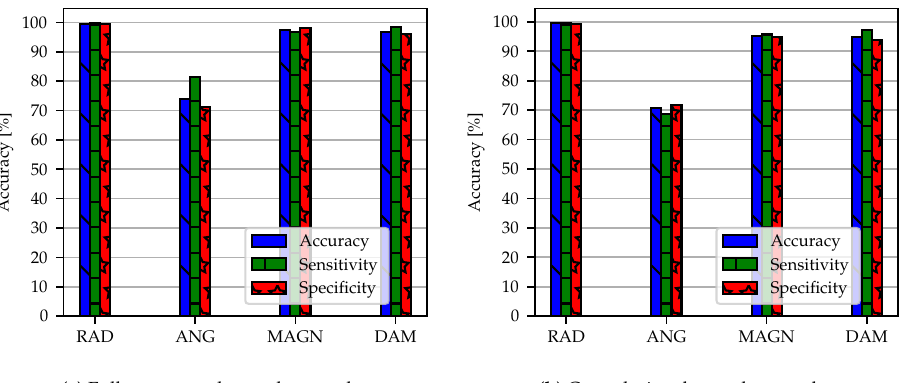
(b) Convolutional neural network. Figure 9. Classification results with an augmented data set for the two network architectures: FC ( a ) with models FC-AD-Pure-RAD/-ANG/-MAGN/-DAM and CNN ( b ) with models CNN-AD-Pure-RAD/-ANG/-MAGN/-DAM. The data set contains in total 7920 spectra. Three bars corresponding to accuracy, sensitivity and specificity are shown.